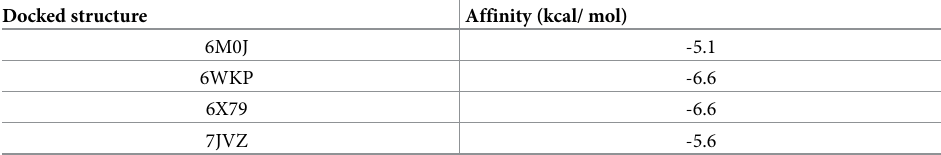
Table 1. Docking pose of D-GlcNAc with the highest affinity (lowest kcal/ mol) to each of the tested proteins from AutoDock Vina.